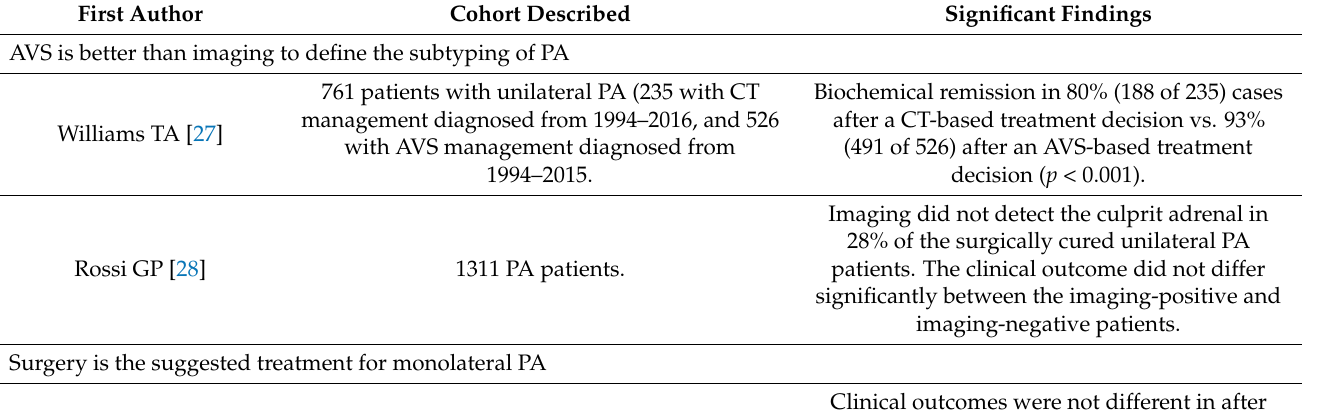
Table 5. Key points of the review, presented in the five clinical cases presented, and most relevant studies in the